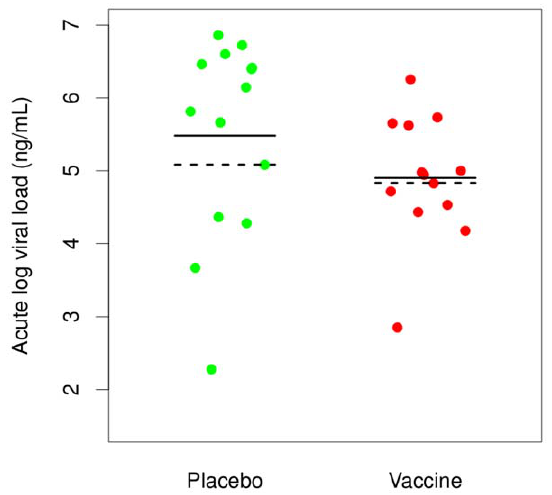
Figure 5. Acute Log 10 Viral Load. The distribution of acute log 10 viral load values in vaccine and placebo groups. Solid lines correspond to observed means and dashed lines correspond to means estimated using the multiple imputation